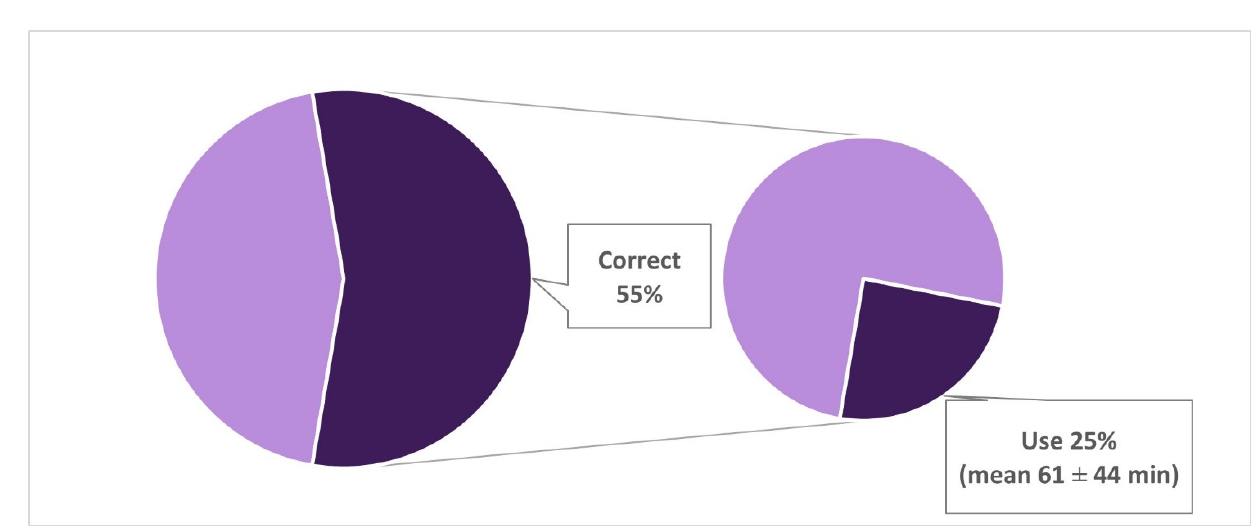
Figure 3. Comparison between opinions about the correct time of use by children aged 0–2 years and responses about the actual use (Correct answer = zero minutes) [21]. Analyses limited to parents having only children aged 0–2 years.